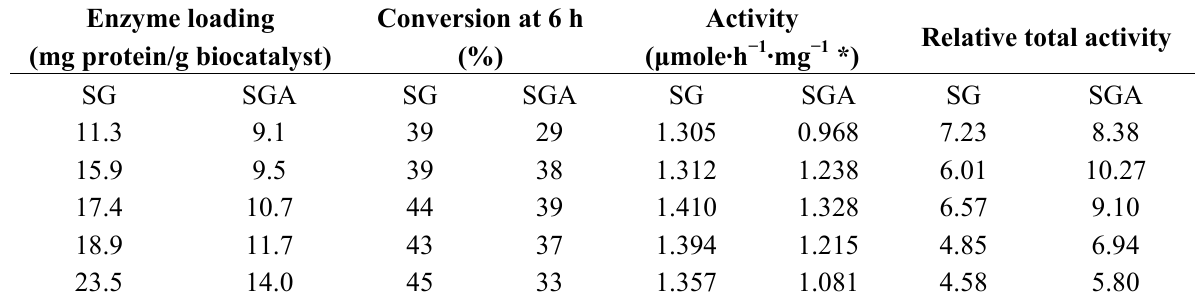
Table 1. Influence of enzyme loading on catalytic efficiency of sol-gel entrapped (SG) and entrapped and adsorbed (SGA) CaLB lipase in the acylation of 2-octanol at 40 °C. Enzyme